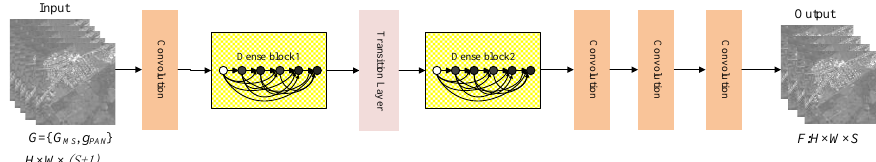
Figure 4. The architecture of DCCNP for pan-sharpening.